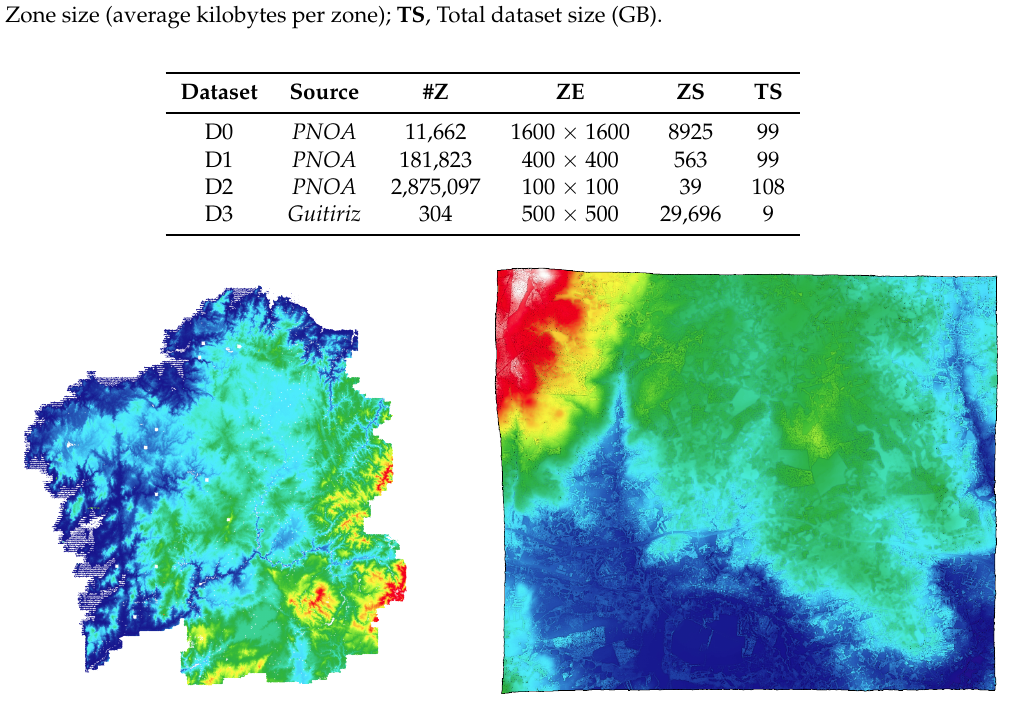
Table 2. Properties of the datasets used for the analysis. #Z , Number of zones; ZE , Zone extent (meters);